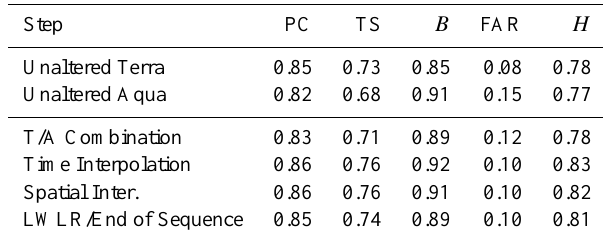
Table 3. Evaluation statistics for each step of the